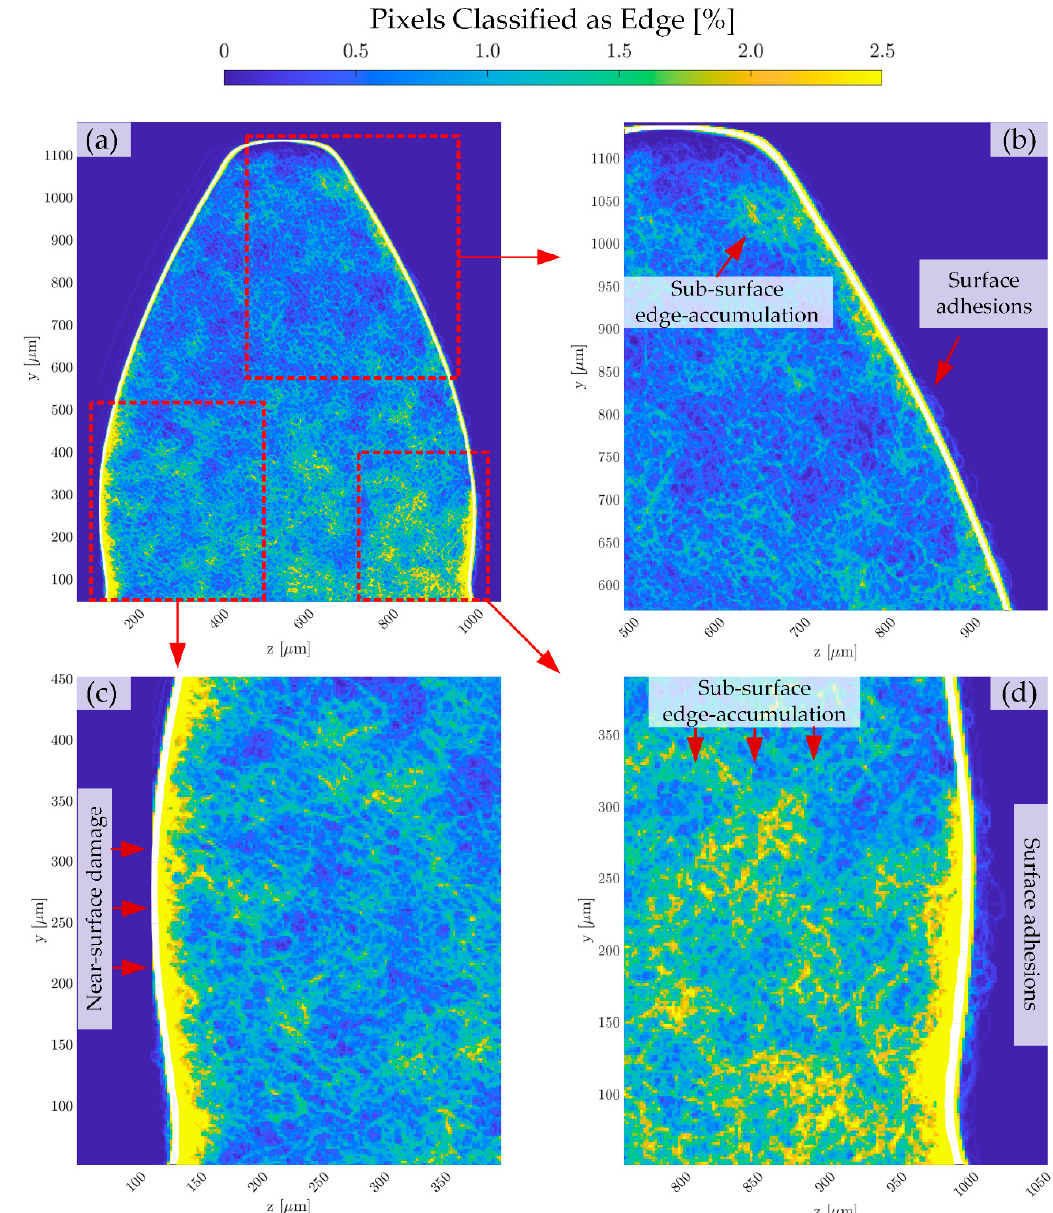
Figure 9. XMT analysis of a gear lubricated by Heritage Oil B. ( a ) Overview of the internal edge distribution as detected by the employed XMT algorithm. ( b ) Detailed view of the addendum part of the gear on the driven side, indicating slight accumulation of subsurface damage. ( c ) Detailed view of the dedendum part of the driving side, indicating near-surface damage. ( d ) Detailed view of the dedendum part of the driven side, indicating extensive subsurface edge accumulations, interpreted as early signs of crack formation.